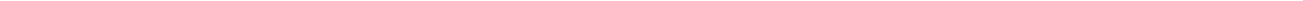
Fig. 6 Functional recovery of de fi cient BMSCs through Lactobacillus supplementation in the rat hypoxia model. a Lactobacillus casei CRL431 ( + ) or saline ( − ) was administered intragastrically to rats housed in normoxic or hypoxic chambers ( n = 9 per group). DNA was extracted from stool samples and subjected to real-time qPCR analysis to assess the levels of Lactobacillus DNA. b The D -galactose concentration in peripheral blood samples was detected in the rats described in a . c Rat intestines were subjected to H&E staining. d Intestines from the rats described in a were subjected to ELISA of LCT activity. e – h BMSCs from rats described in a were isolated and cultured to passage 3. Cell lysates were analysed for ageing-related proteins by western blotting ( e ). Cells were subjected to MTT assays ( f ), SA- β -gal analysis (scale bar, 100 μ m) ( g ) and FACS analysis ( h ) to assess cell growth, premature senescence status and cell cycle distribution, respectively. Data represent the means± SD from three independent experiments, and statistical signi fi cance was analysed by one-way ANOVA followed by Tukey – Kramer multiple comparisons. a P < 0.05 compared with normal/ − . b P < 0.05 compared with hypoxia/ − . c P < 0.05 compared with normal/ + . d P < 0.05 compared with hypoxia/ + (** P <